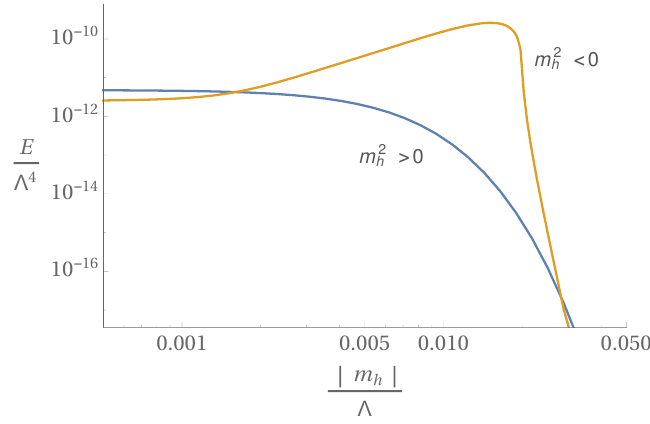
Figure 2 . The energy E transferred to a sector during reheating as a function of the in(cid:13)aton independent component of its Higgs mass squared m 2 relative to the UV cuto(cid:11) of the theory (cid:3). p h The in(cid:13)aton couplings are given by eq. (3.4) with g = 0 : 02 and _ (cid:30) = (cid:3) 2 = 8, and at late times the in(cid:13)aton decouples and the total Higgs mass squared parameter is m 2 . Above j m h j (cid:24) 0 : 02(cid:3) the h evolution is adiabatic and the energy transfer is exponentially suppressed. The in(cid:13)aton couplings are such that if (cid:0) g 2 (cid:3) 2 < m 2 < 0 there is a moment when the physical Higgs mass vanishes, and h signi(cid:12)cantly more energy is transferred than if m 2 > h